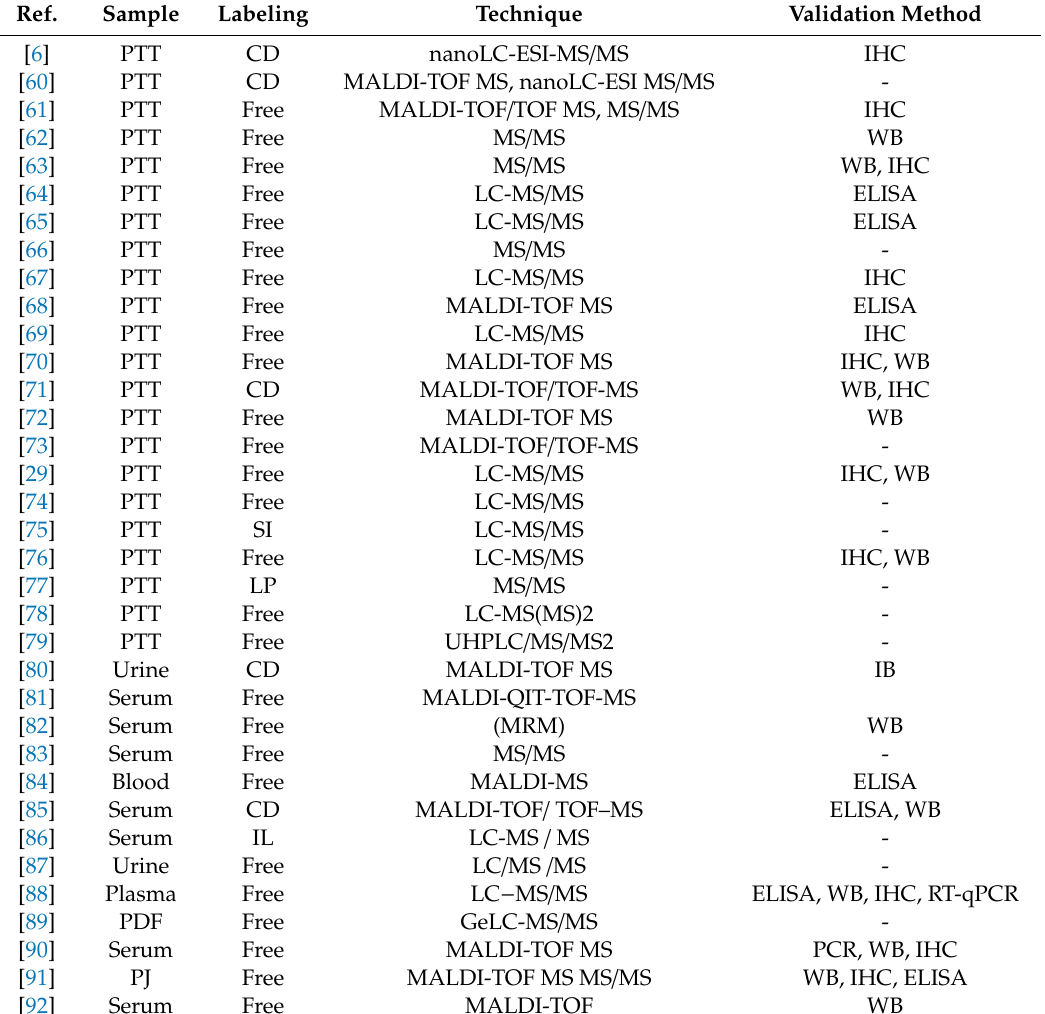
Table 2. Description of publicly available human proteomic studies used in the proteome meta-analysis.